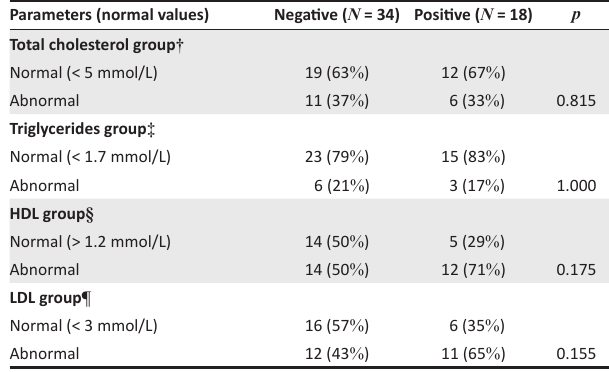
TABLE 4: Percentage of patients with abnormal lipogram values.